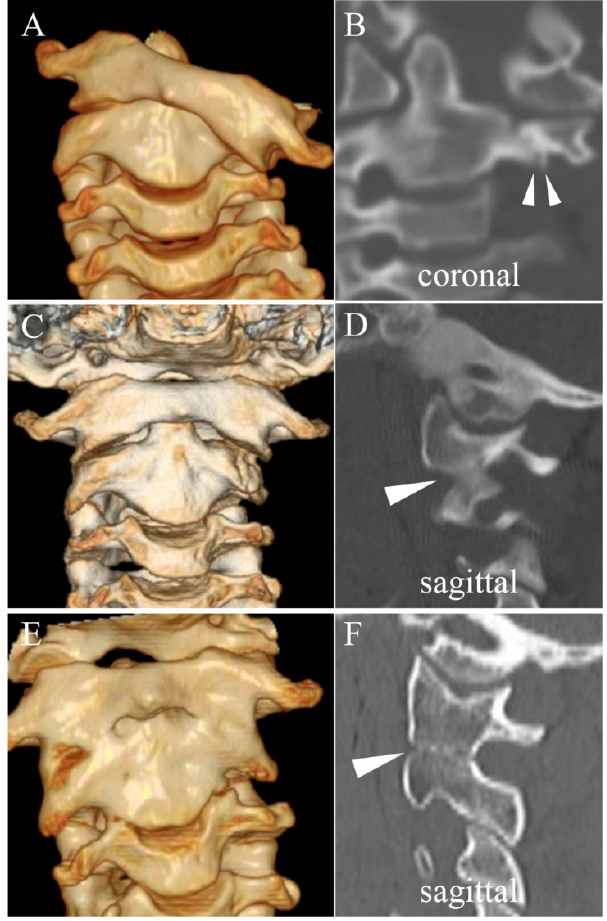
Figure 2. Representative osseous fusion case (Case 9) 7-year-old female patient with Fielding type 3 and Ishii grade 3 ( A ). Direct osseous contact of C1/C2 facet on the dislocated side at initial visit (solid arrowhead in ( B )), persisted after reduction and during halo fixation ( C ), solid arrowhead in ( D ), and resulted in spontaneous osseous fusion at the final follow-up ( E ), solid arrowhead in ( F ). Duration of halo fixation was 2.9 months.